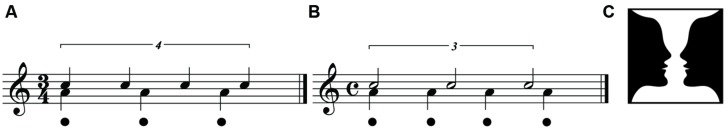
Cross-rhythms. (A) Three-beat triple meter with four-beat pattern as counter-rhythm. (B) Four-beat duple meter with three-beat counter-rhythm. Dots below the staves designate the tactus. (C) The bistable percept of Rubin’s vase.